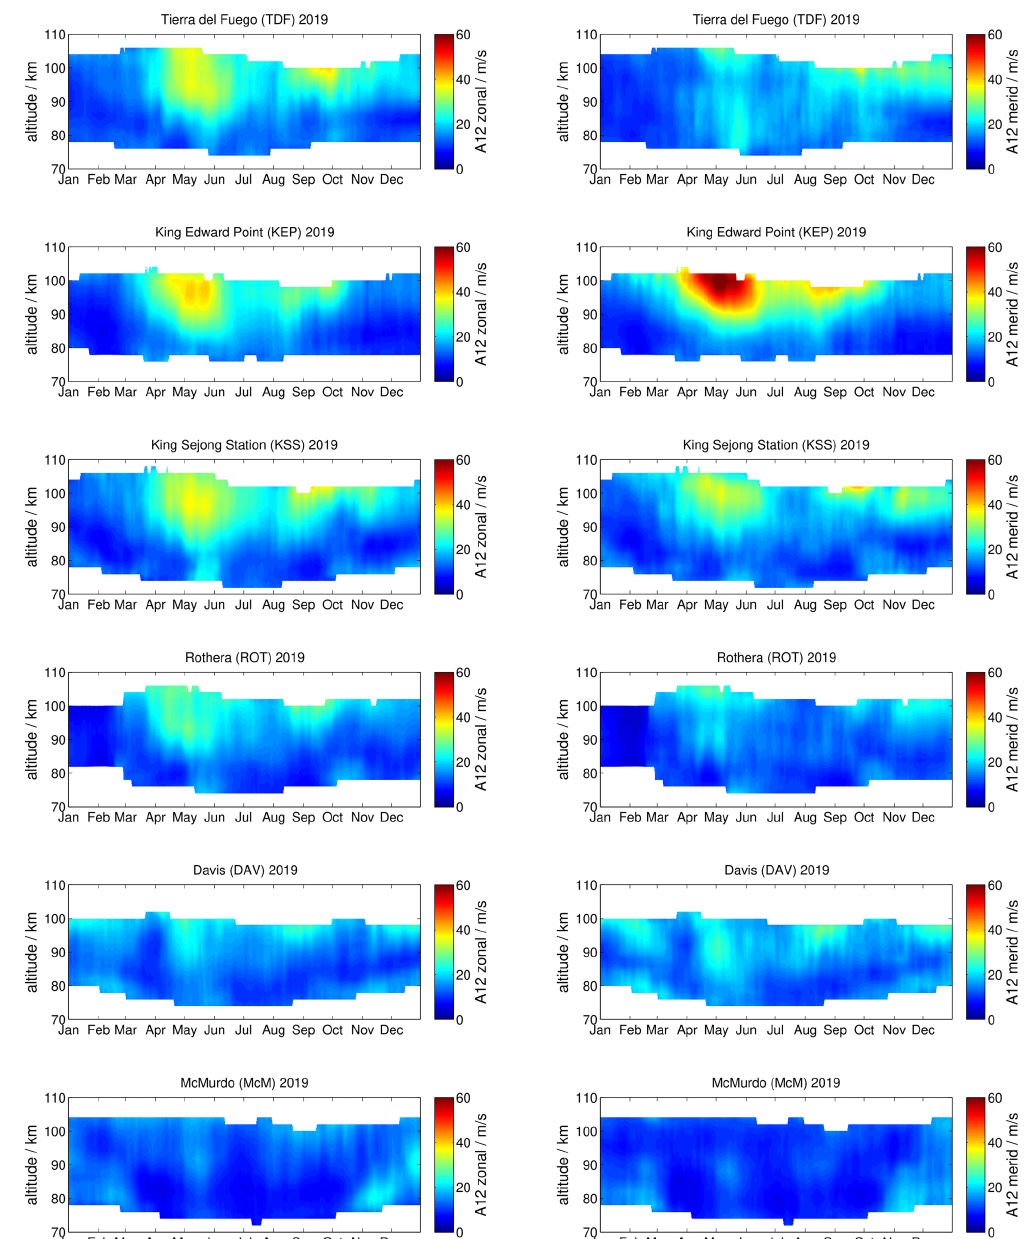
Figure 5. Same as Fig. 2 but for the semidiurnal tidal